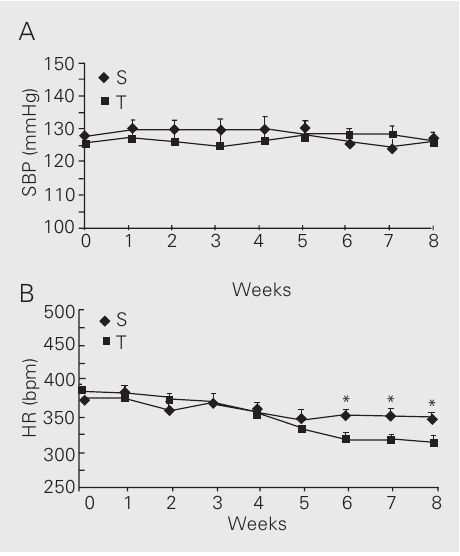
Figure 1. Systolic blood pressure (SBP, Panel A) and heart rate (HR, Panel B) during the weeks of exercise training or inactivity. 0, Before exercise training or in- activity period. Data are reported as means ± SEM for 12 rats in each group. Note that SBP val- ues were similar for sedentary (S) and swimming-trained (T) rats, while a significant resting bradycardia was observed in T rats following the sixth week of exercise training. *P ≤ 0.05 com- pared to T rats (one-way ANOVA for repeated measures followed by post hoc Tukey